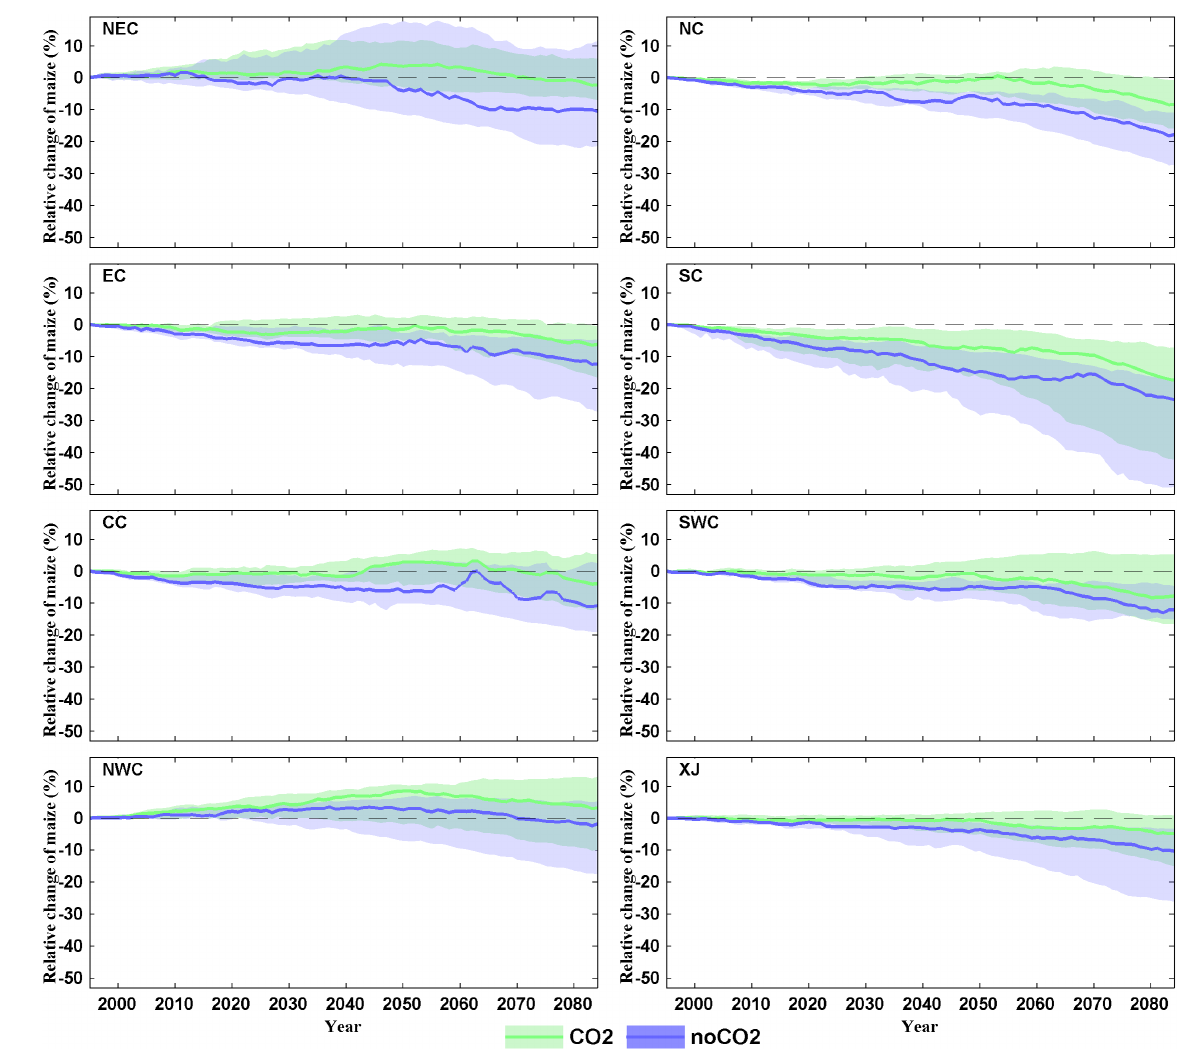
Figure 4. The relative change in the simulated maize yield in the eight regions with and without the CO 2 effect. The MMs and the 25th and 75th percentiles of the model pairs are